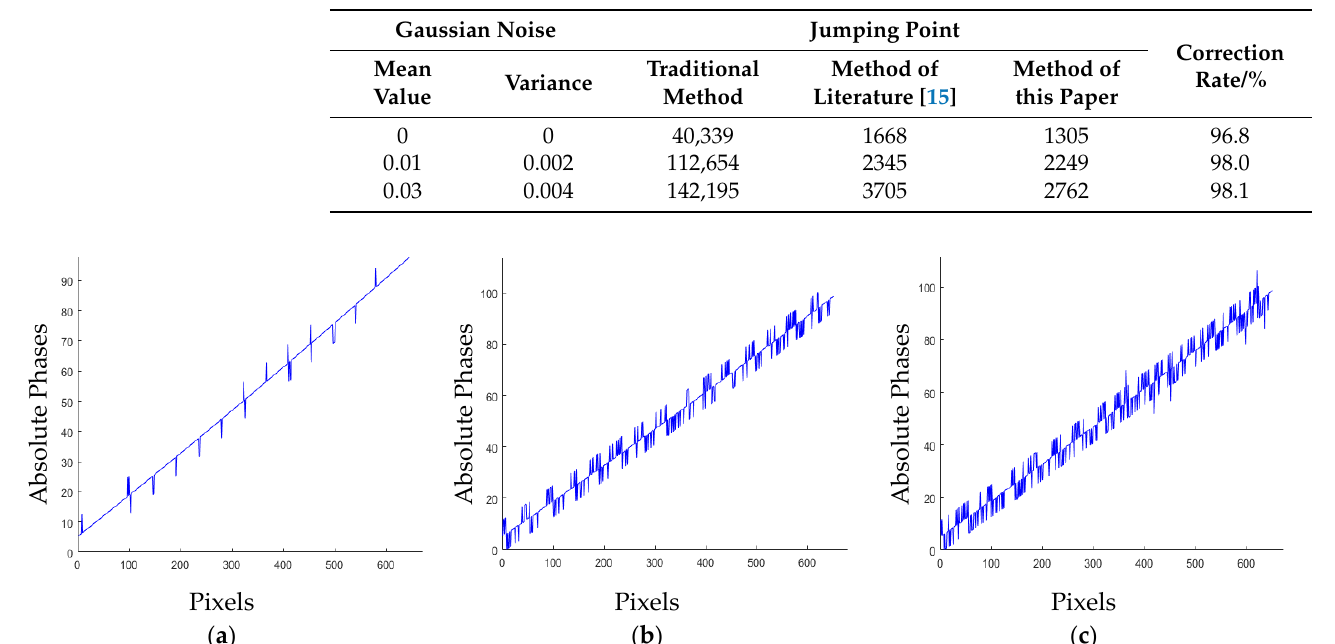
Table 1. Jumping error points.